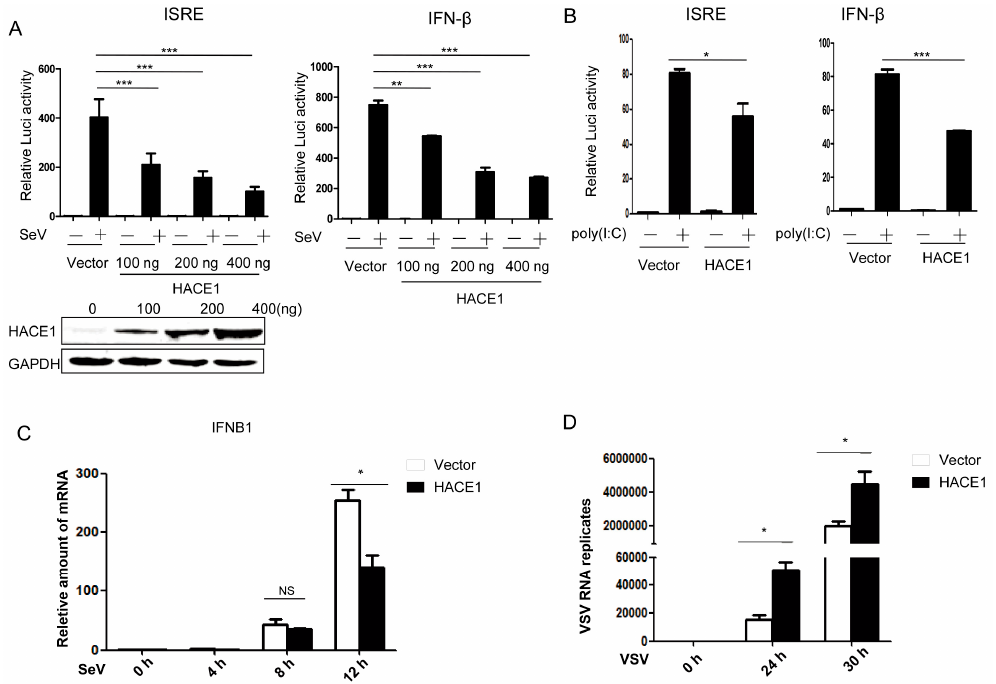
Figure 1. HACE1 negatively regulates virus-induced type I IFN signaling. ( A ) Overexpression